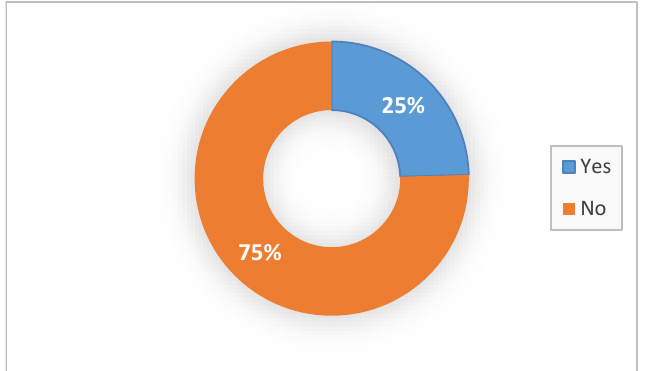
Figure 2. Clinics which are implementing the GDPR